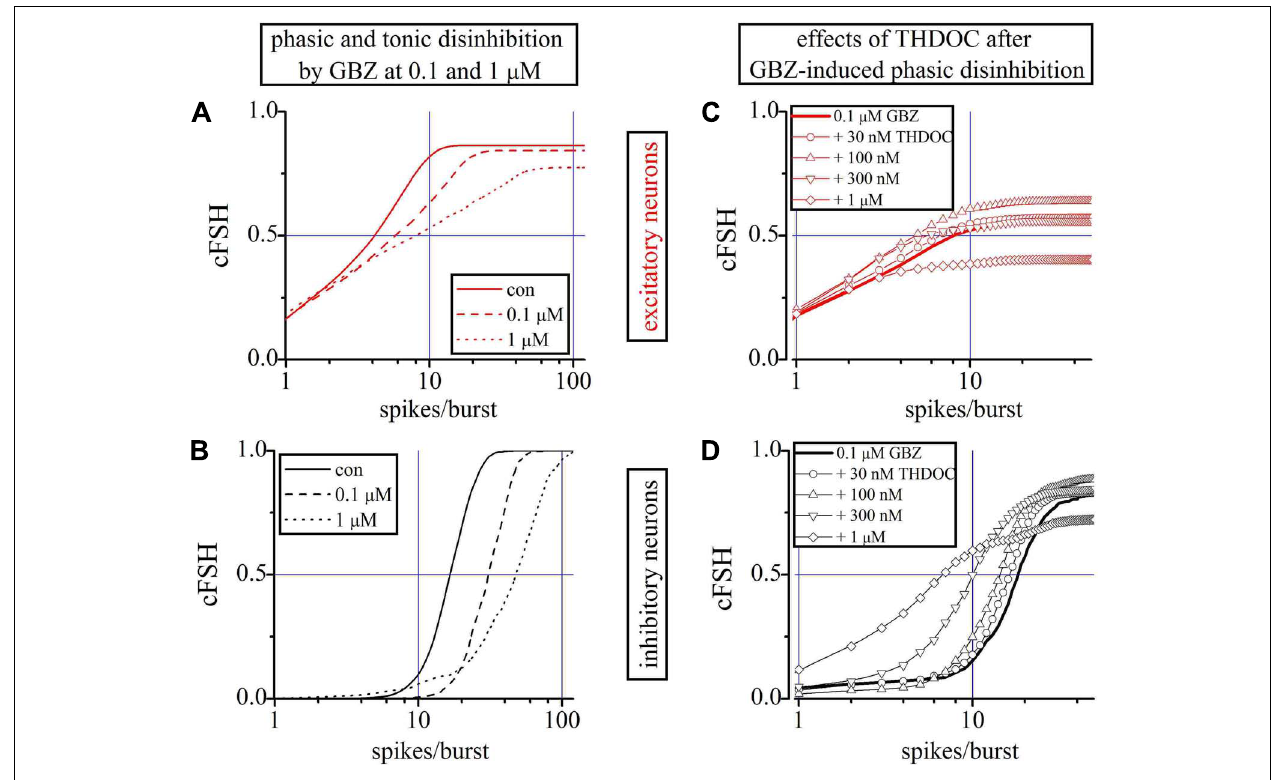
FIGURE 5 | Role of phasic and tonic network inhibition and the THDOC action on partially and totally disinhibited networks. (A,B) Plots of cFSHs of excitatory and inhibitory neuron clusters (control, continuous line; 100 nM GBZ, dashed-line; 1 μ M GBZ, dotted-line). An exemplary experiment in which 84 and 24 excitatory and inhibitory cells were identified. (C,D) Plots of cFSH of excitatory (red) and inhibitory clusters (black) after 0.1 μ M GBZ (continuous line) and duringTHDOC application. Data obtained whenTHDOC was applied on top are shown with